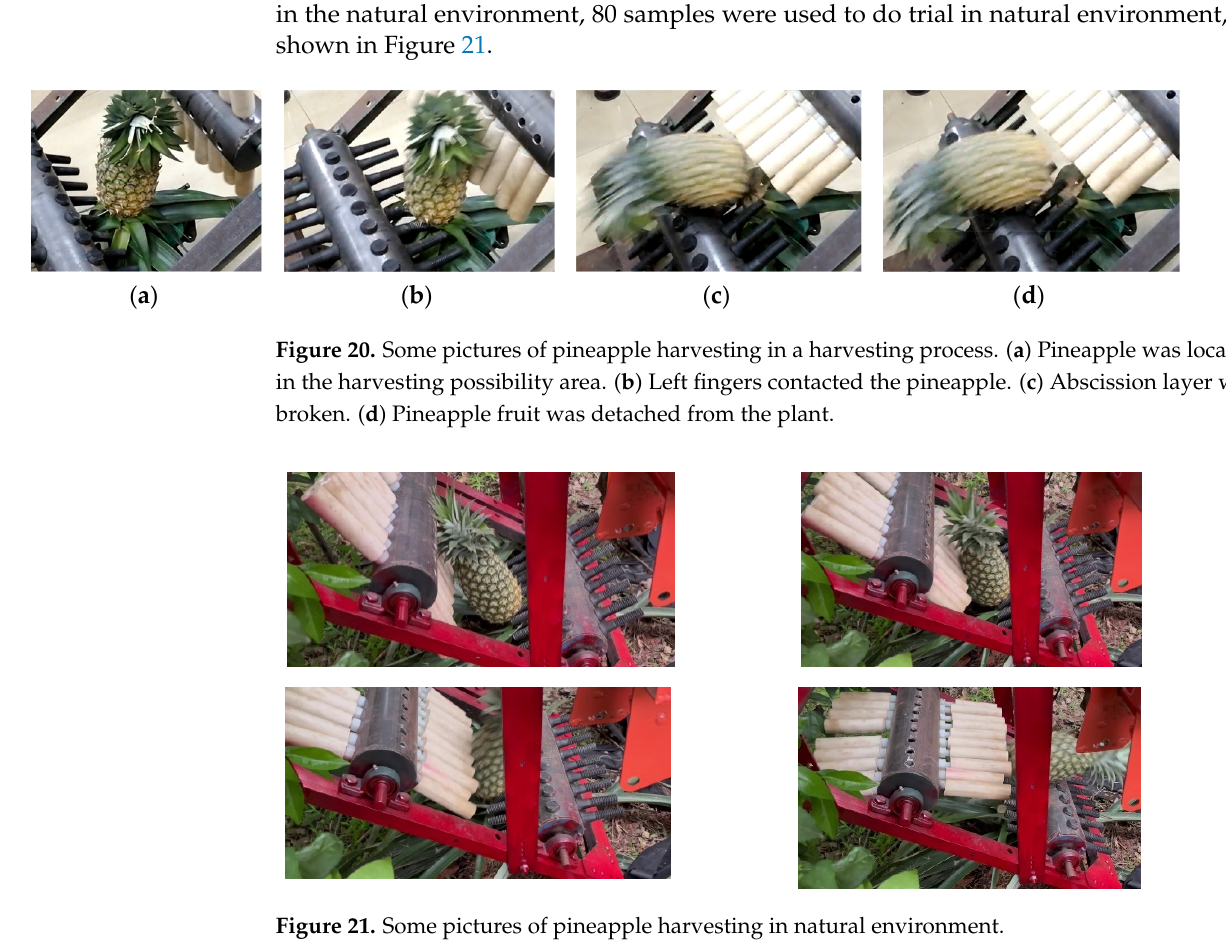
Figure 21. Some pictures of pineapple harvesting in natural environment.